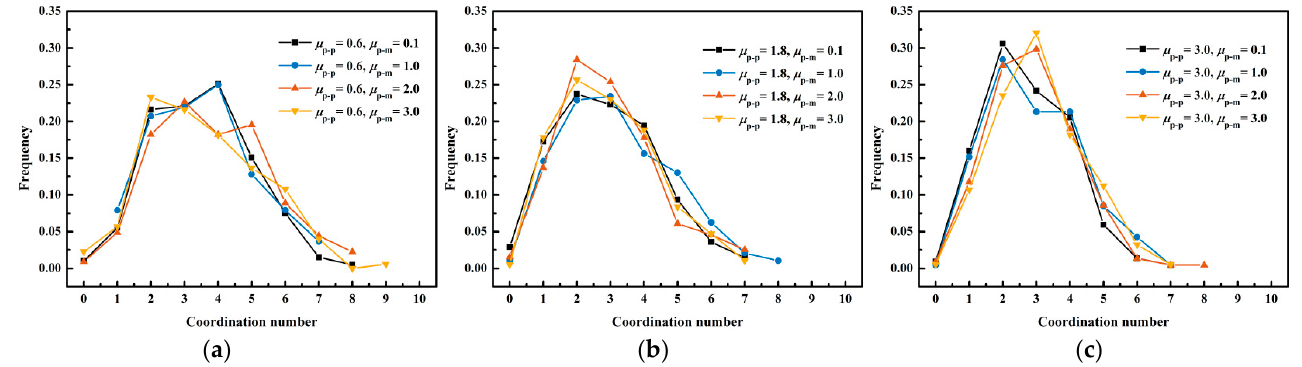
Figure 10. Impacts of the rolling friction coe ffi cient between the lignin particles and membranes on the coordination number distribution ( a ) 𝜇 (cid:2926)(cid:2879)(cid:2926) = 0.6 ; ( b ) 𝜇 (cid:2926)(cid:2879)(cid:2926) = 1.8 ; ( c ) 𝜇 (cid:2926)(cid:2879)(cid:2926) = 3.0 . the coordination number distribution ( a ) µ p − p = 0.6; ( b ) µ p − p = 1.8; ( c ) µ p − p =